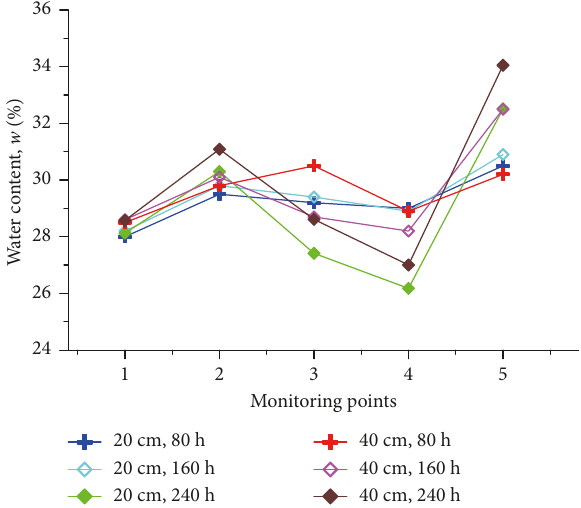
Figure 8: Water distribution in the canal foundation before and after testing.